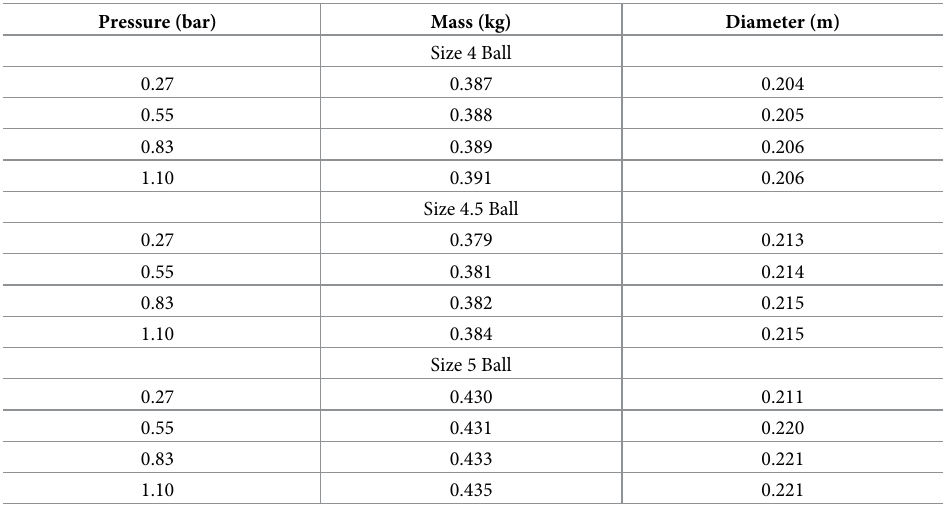
Table 2. Dry soccer ball metrics by